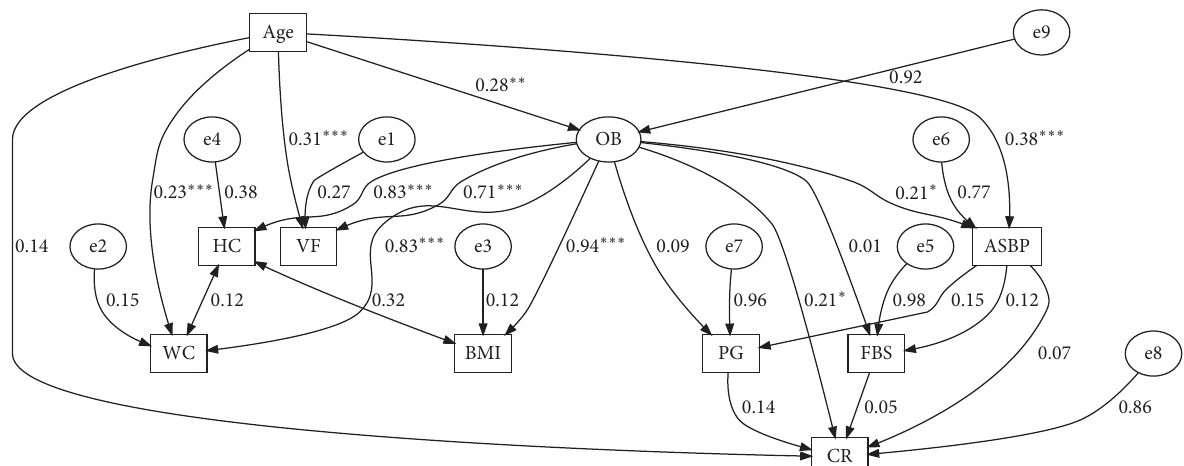
Figure 5: Structural equation modelling assessing the effect of manifest blood pressure (average systolic blood pressure) on type 2 diabetes and coronary risk (Model 4).